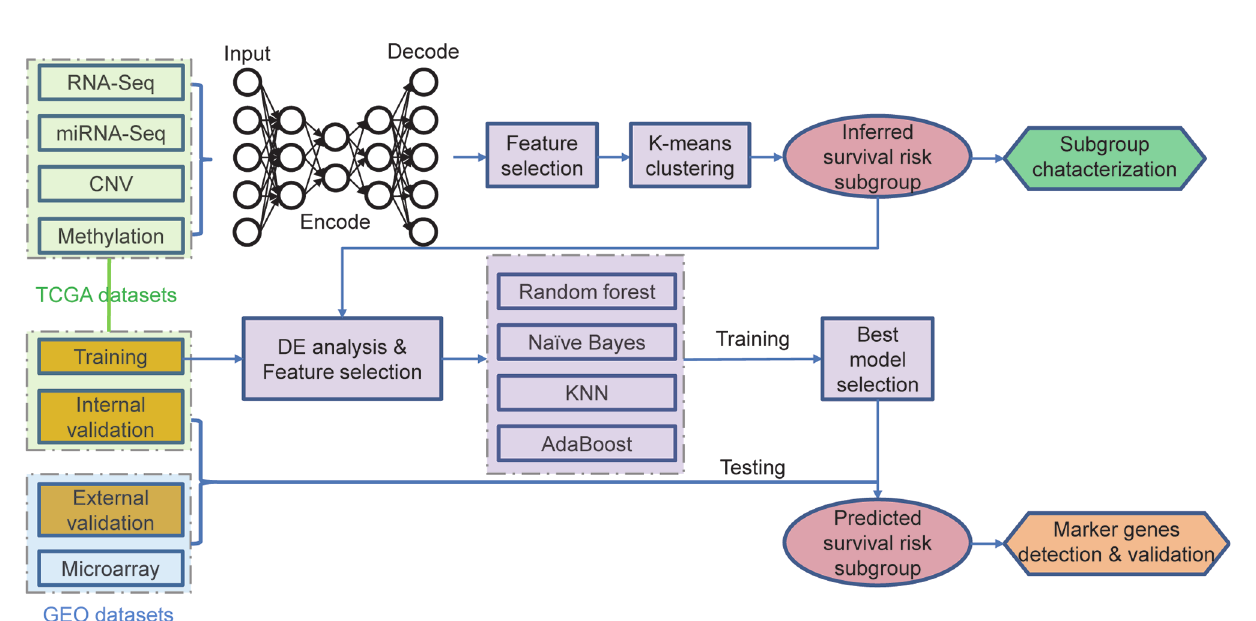
FIGURE 1 | Overall work fl ow for the deep learning-based prognostic subtyping and